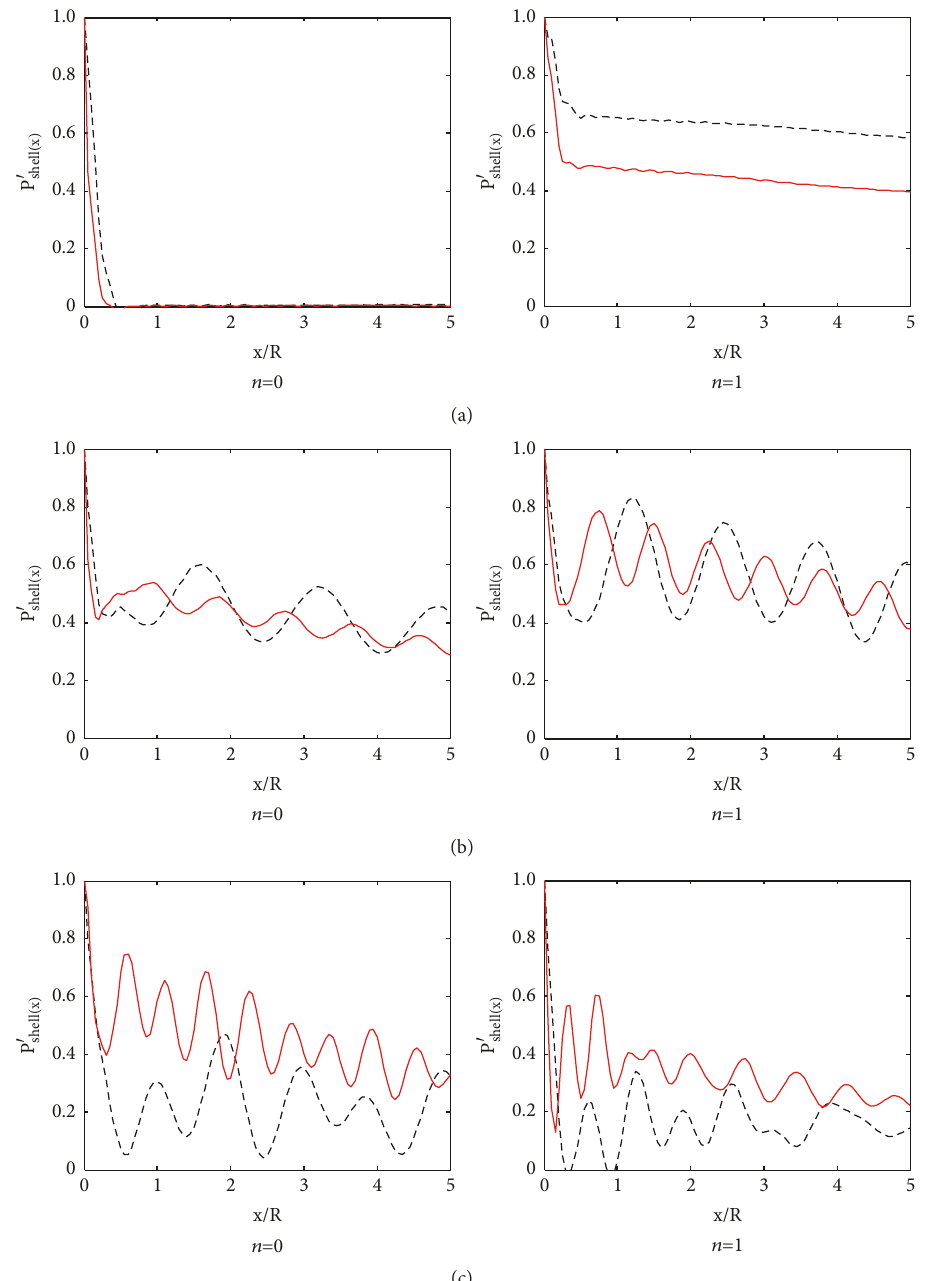
Figure 13: The comparison of power transmitted by the shell with ℎ/𝑅 = 0.075 : (a) Ω = 0.3 , (b) Ω = 1.2 , and (c) Ω = 3.0 ; black dashed line: ℎ/𝑅 = 0.075 ; red solid line: ℎ/𝑅 = 0.0375